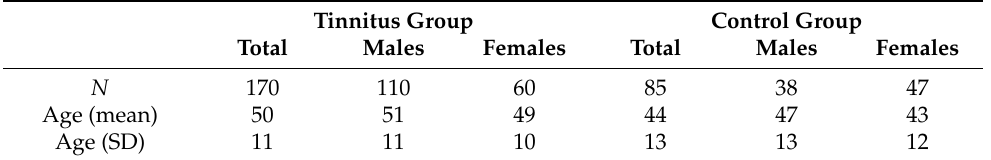
Table 1. Age description of participants. Tinnitus Group Control Group Total Males Females Total